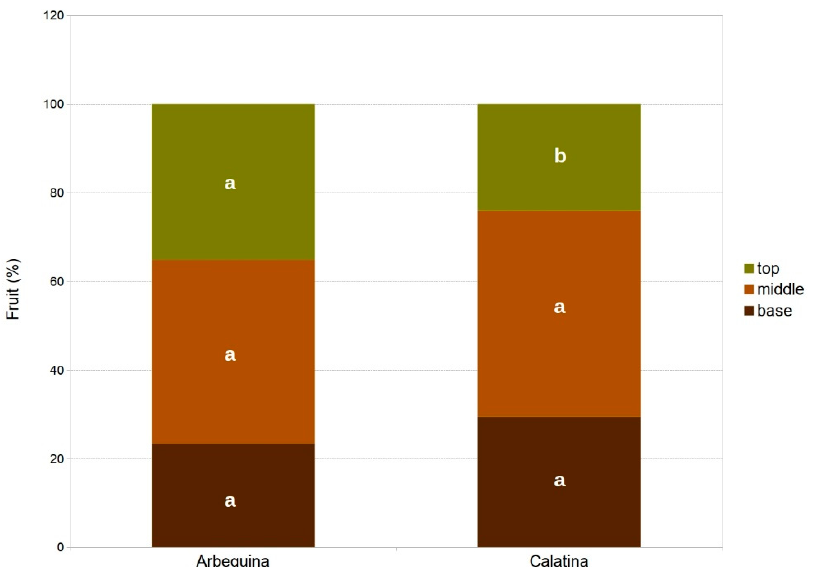
Figure 5. Percentage fruit in the top, middle, and base portions of the bearing shoots from ‘Arbequina’ and ‘Calatina’ olive trees. Different letters indicate significant differences between cultivars for each shoot portion (Tukey’s test, p < 0.05).